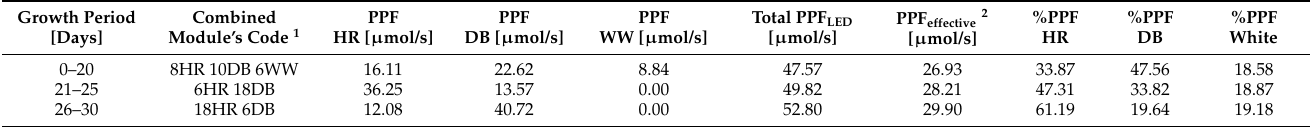
Table 10. Light recipe used in the validation